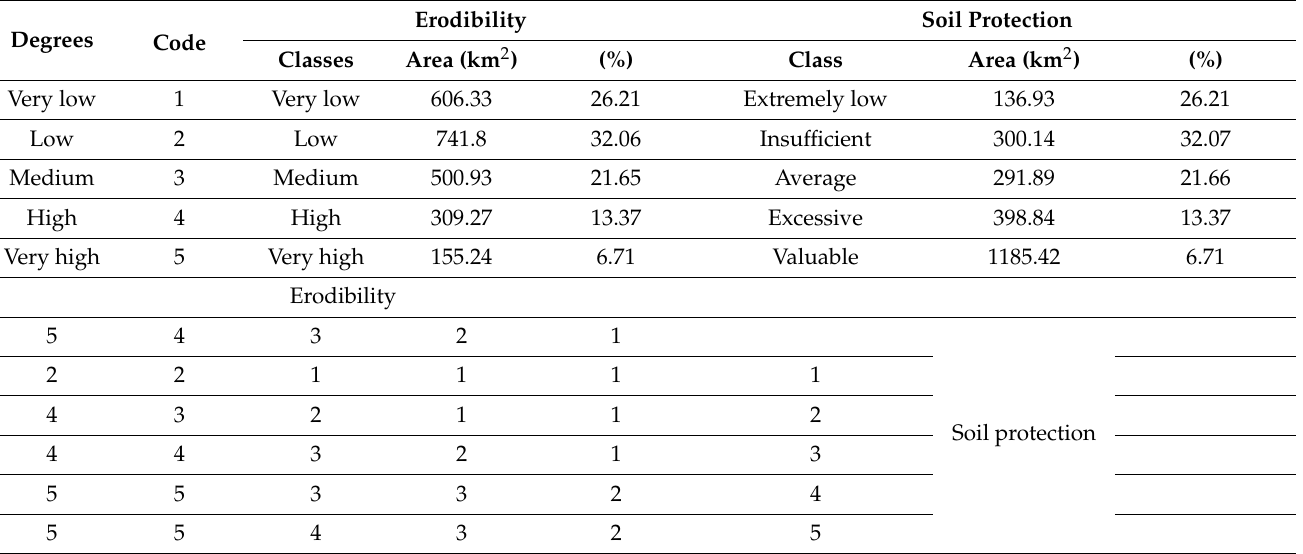
Table 4. Correlation matrix of surface susceptibility to erosion and soil protection according to PAP/RAC